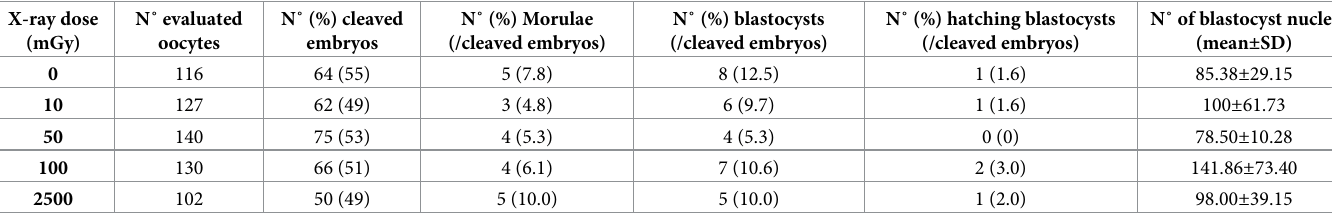
Table 3. Effects of oocyte exposure to low-dose X-ray radiations before IVM on oocyte in vitro developmental competence and blastocyst quality. X-ray dose (mGy)